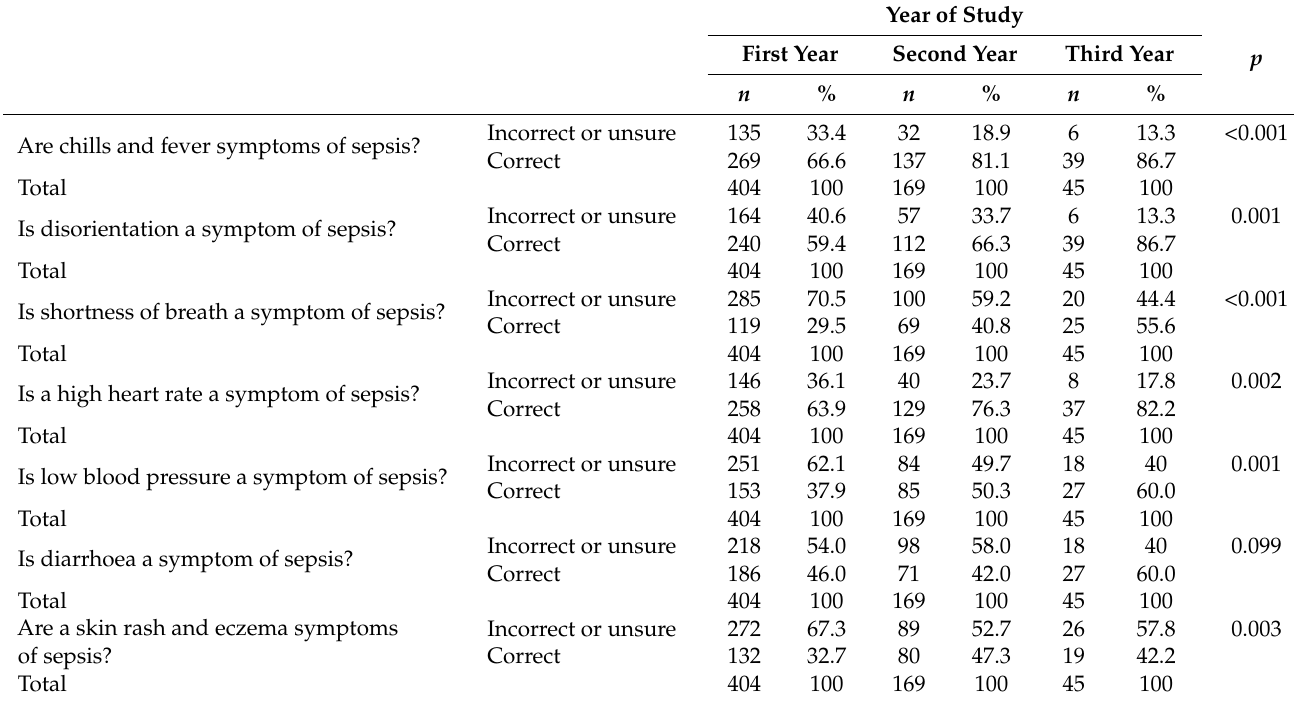
Table 4. Percentage and number of students with correct answers to “Knowledge of the symptoms of sepsis” according to their year of